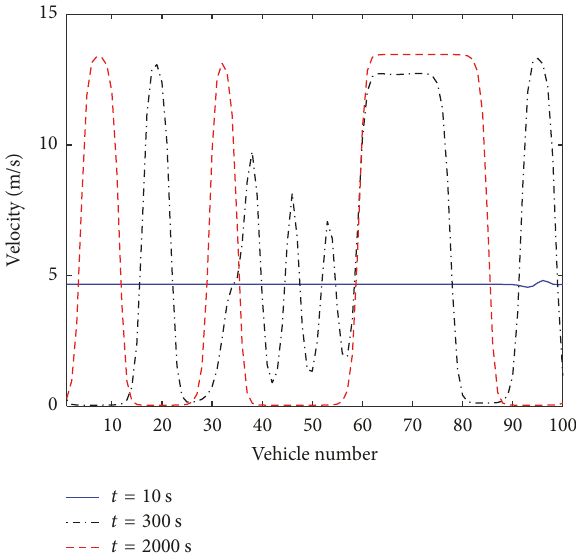
Figure 3: The snapshots of the velocity of all vehicles at different times for manual driving.